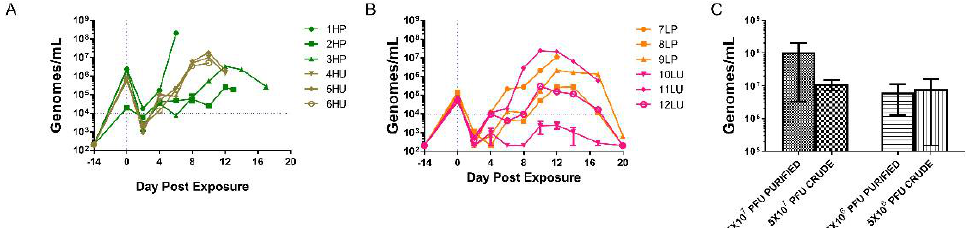
Figure 4. Viremia as assessed via quantitative polymerase chain reaction of EDTA whole blood. Evaluation of the genomic viral loads were conducted every two days (and at euthanasia, when possible) for the high dosed ( A ) and low dosed ( B ) monkeypox virus exposed groups. The peak values obtained for individual animals were combined per group ( C ), and the log 10 transformed values were statistically evaluated using a two-tailed t -test between the two high dose groups and between the two lower dose groups. There was no statistical difference between either the high ( p = 0.3348) and low ( p = 0.5001). HP, high dose purified; LP, low dose purified; HU, high dose crude; LU, low dose crude.